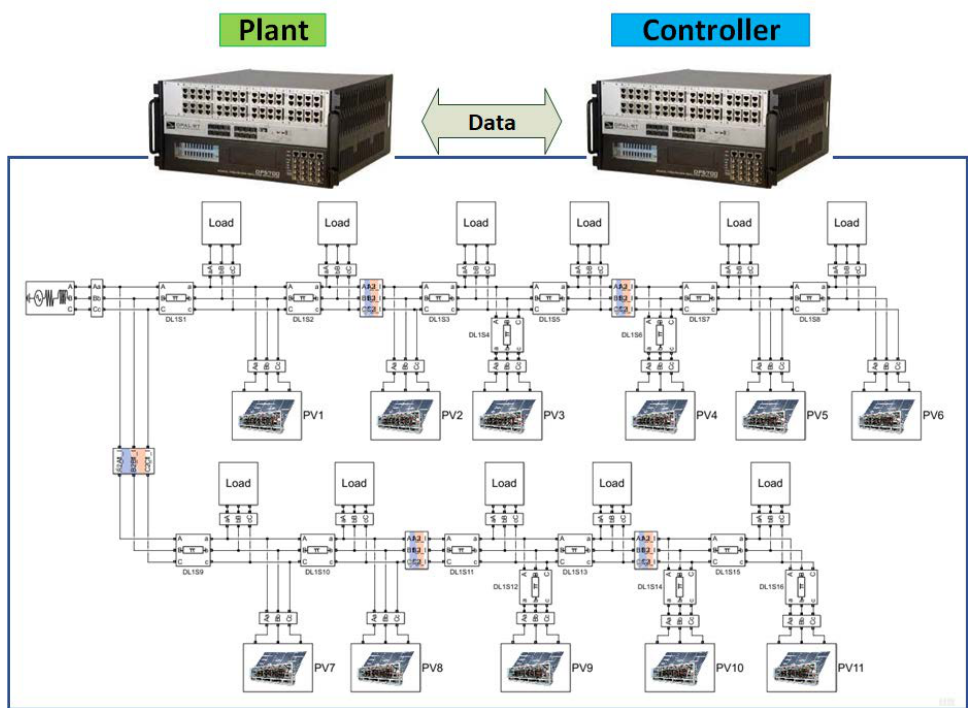
Figure 7. Virtual STATCOM Simulation Model.